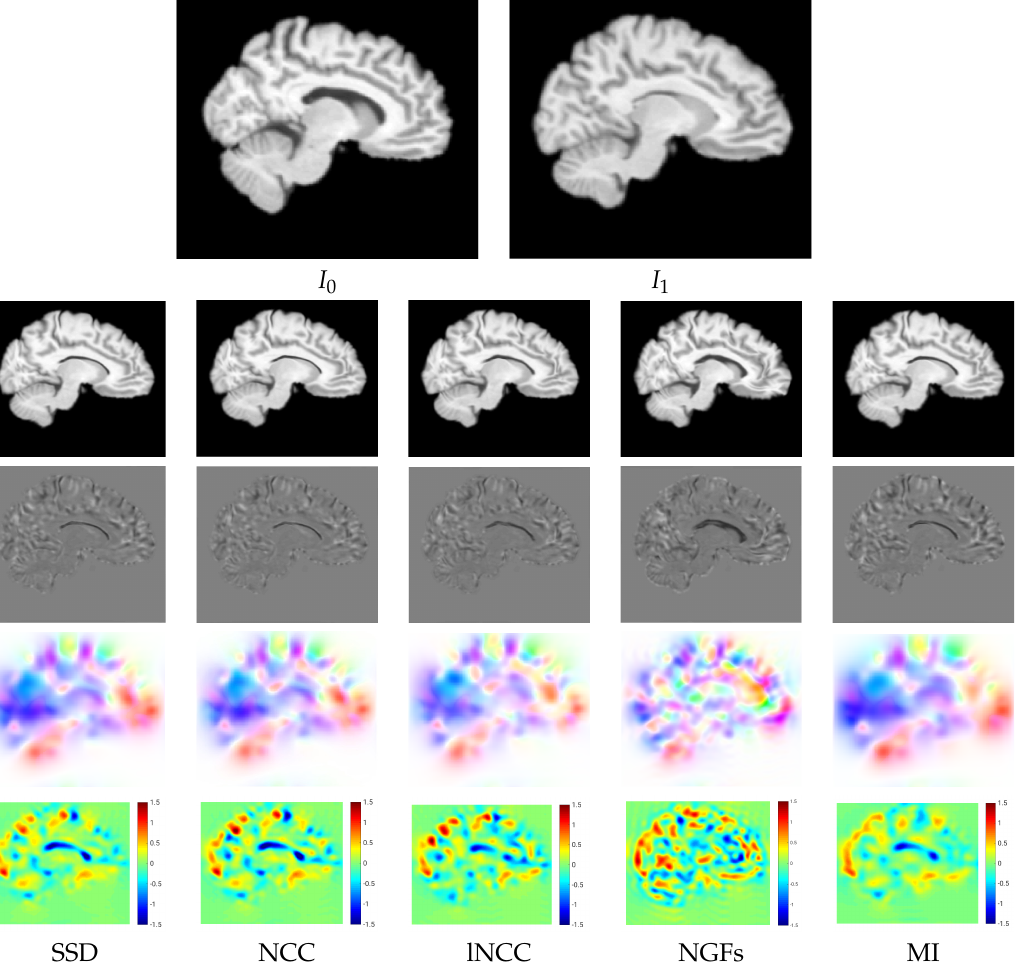
Figure 5. NIREP16. BL Variant II of PDE-LDDMM. Multi-resolution experiments. Sagittal view of the warped sources, the intensity differences after registration, the velocity fields, and the logarithm of the Jacobian determinants after registration for the different image similarity metrics. The results for SSD, NCC, lNCC, and NGFs are obtained with Gauss–Newton optimization, while for MI gradient-descent is used.